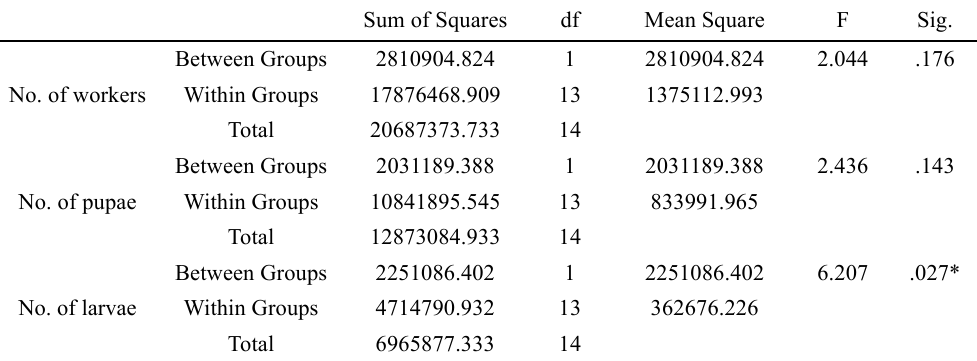
Table 6 . Variation in the number of the different caste with respect to the presence or absence of the queen. ANOVA, *p ≤ 0.05, n =